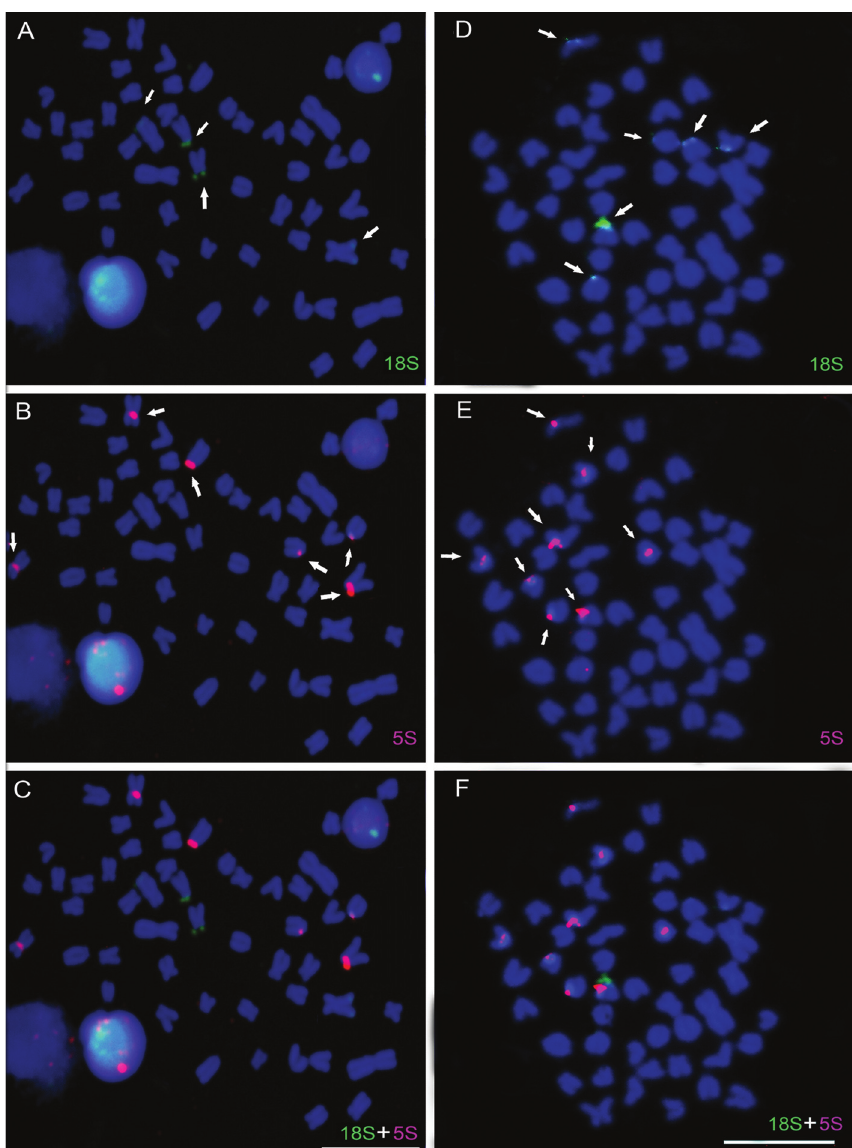
Fig. 7. Fluorescence in situ hybridization with 18S rDNA (A and D) and 5S rDNA (B and E) probes. Overlapping of images (C and F). Ribeirão Grande (1850 m a.s.l.), images (A-C); Ribeirão Grande (662 m a.s.l.), images (D-F). The arrow points indicate region of hybridization. Bar =